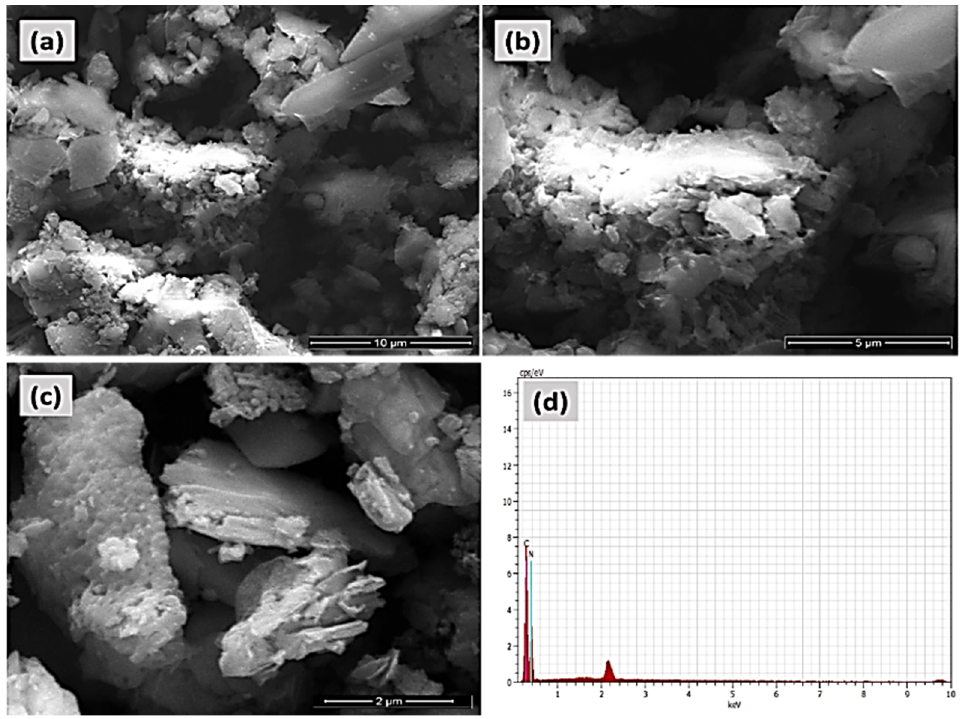
Figure 6. FE-SEM micrograph pictures of ( a – c ) covalent organic polymer (COP-N), and ( d ) EDAX elemental analysis of COP-N.